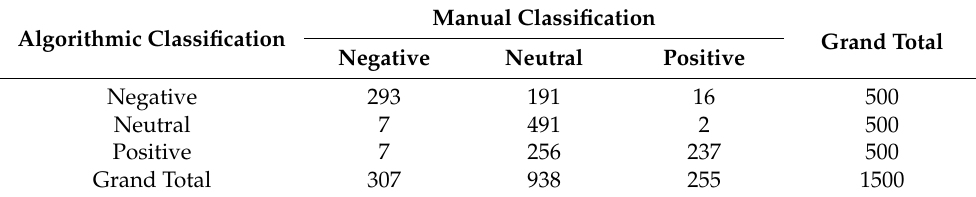
Table 3. Validation of initial VADER sentiment